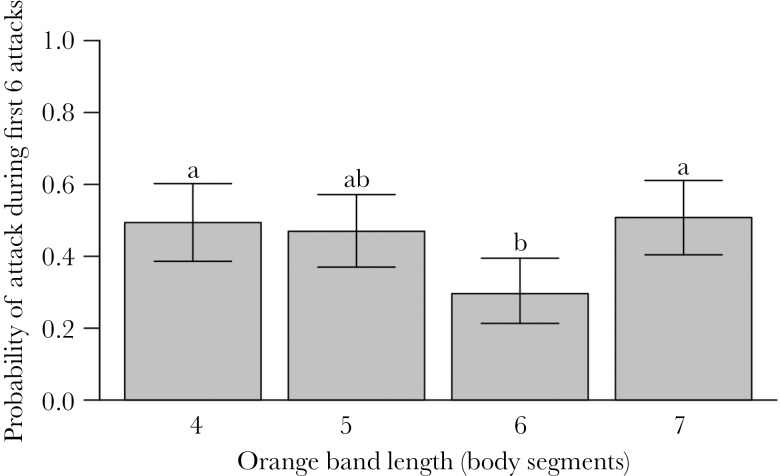
Probability of A. plantaginis caterpillars with varying orange band length being among the first six attacked by P. major in an array of 12 caterpillars (three of each band length). Bars represent 95% confidence interval, and lettering indicates significantly differing band lengths in a Tukey’s post hoc test (n = 34 birds).